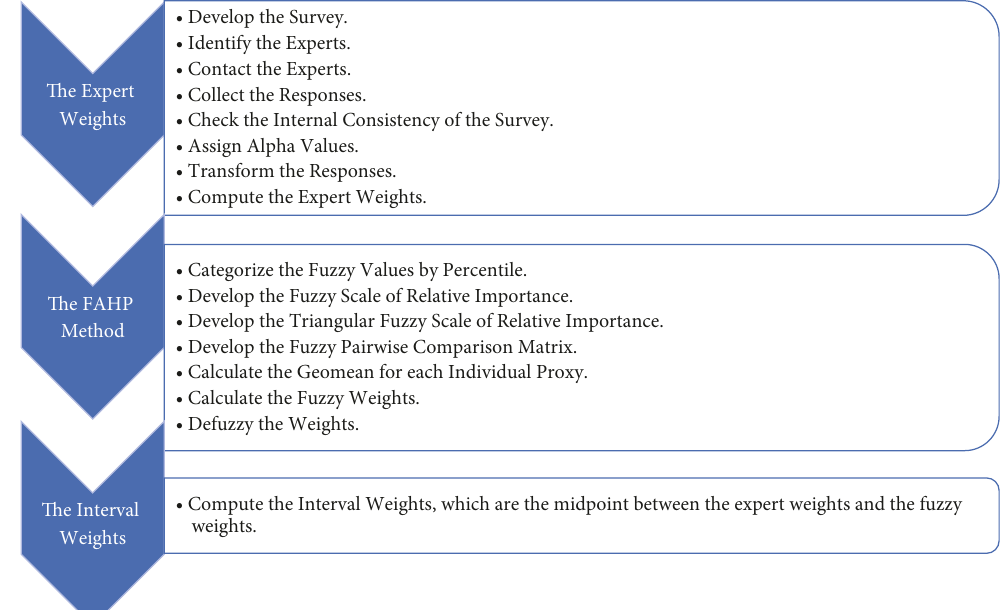
Figure 1: Flowchart summarizing the research